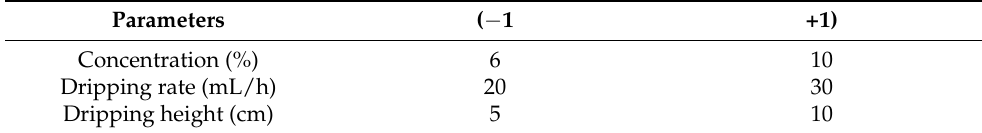
Table 1. Experimental 2 3 factorial planning